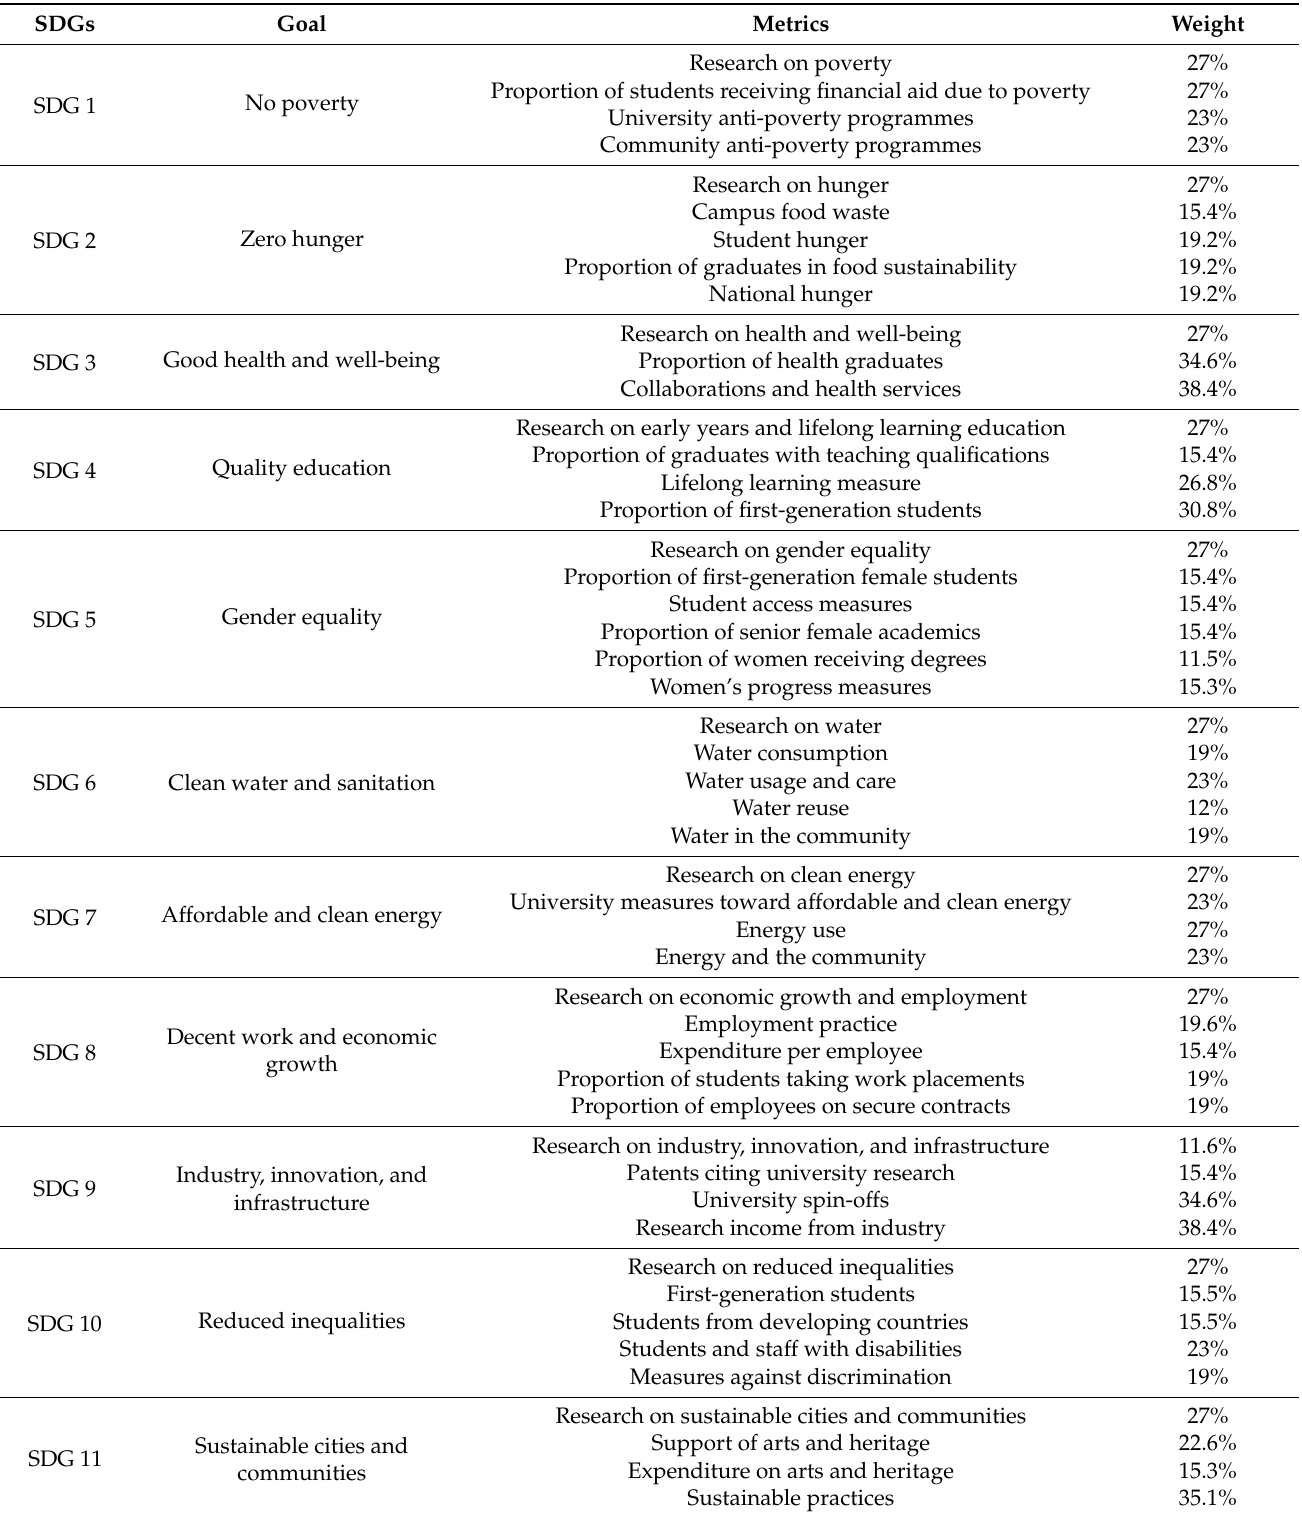
Table 3. THE Impact Rankings